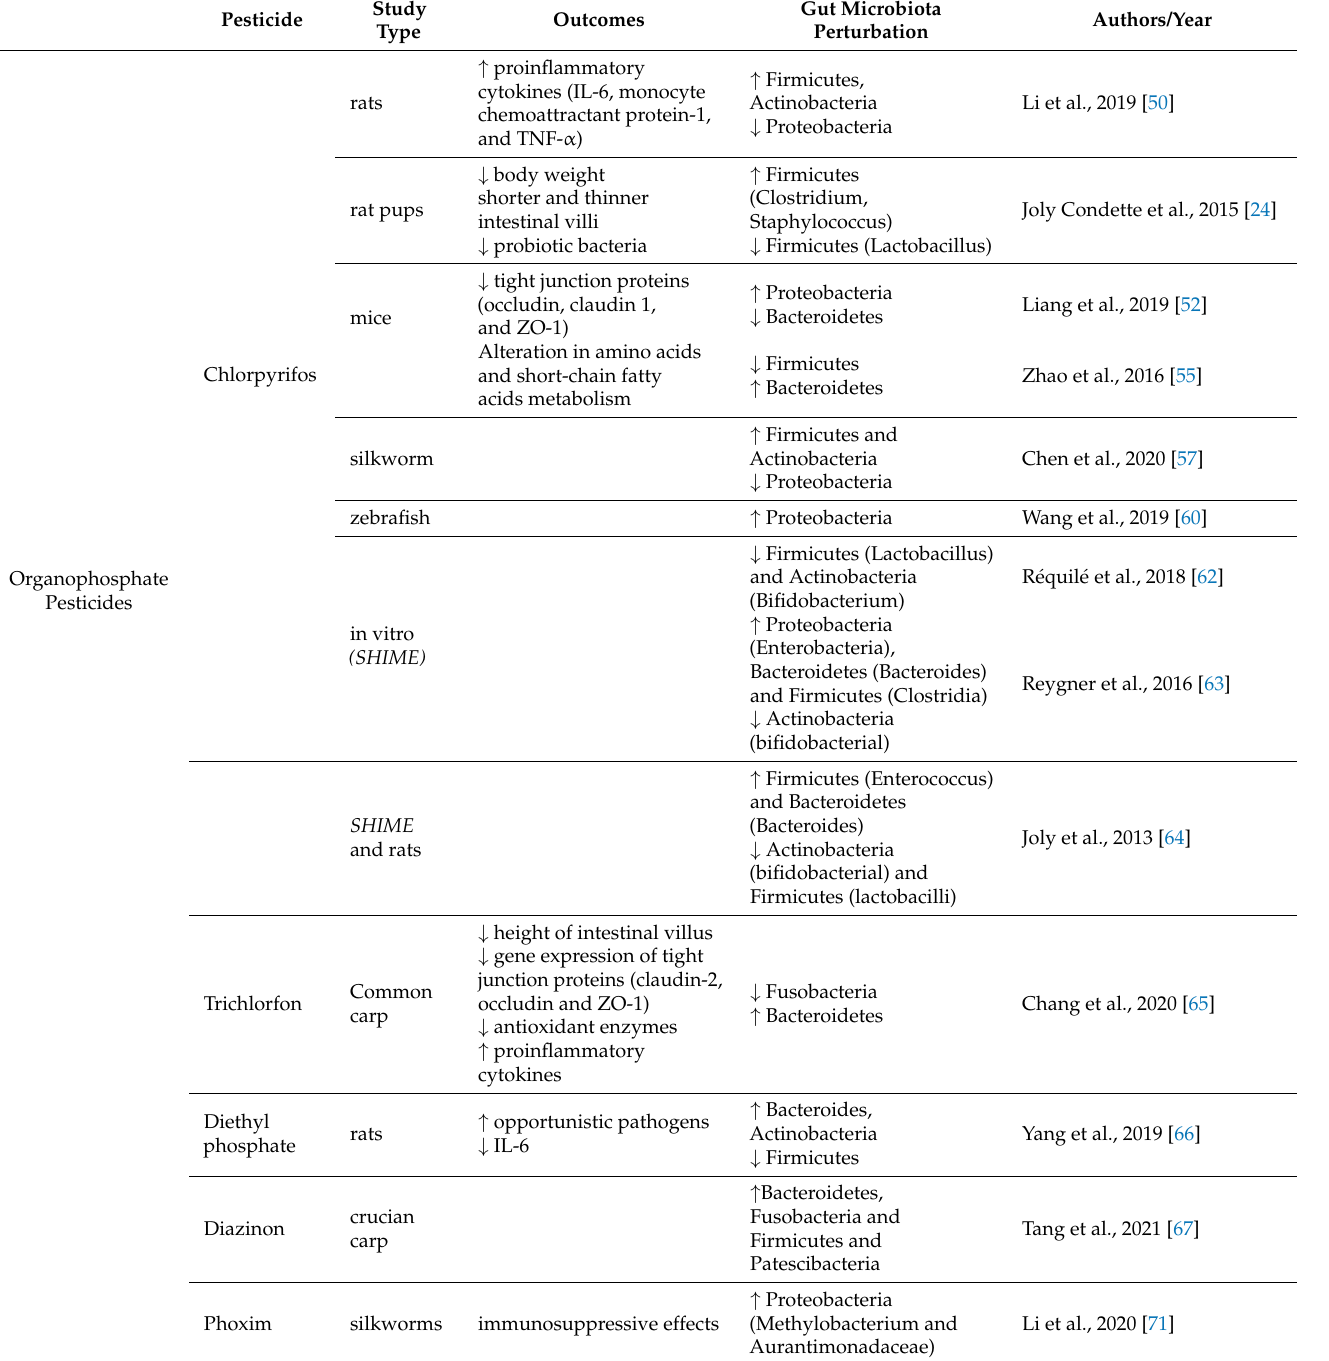
Table A2. Current literature on gut microbiota perturbation due to exposure to organophosphate